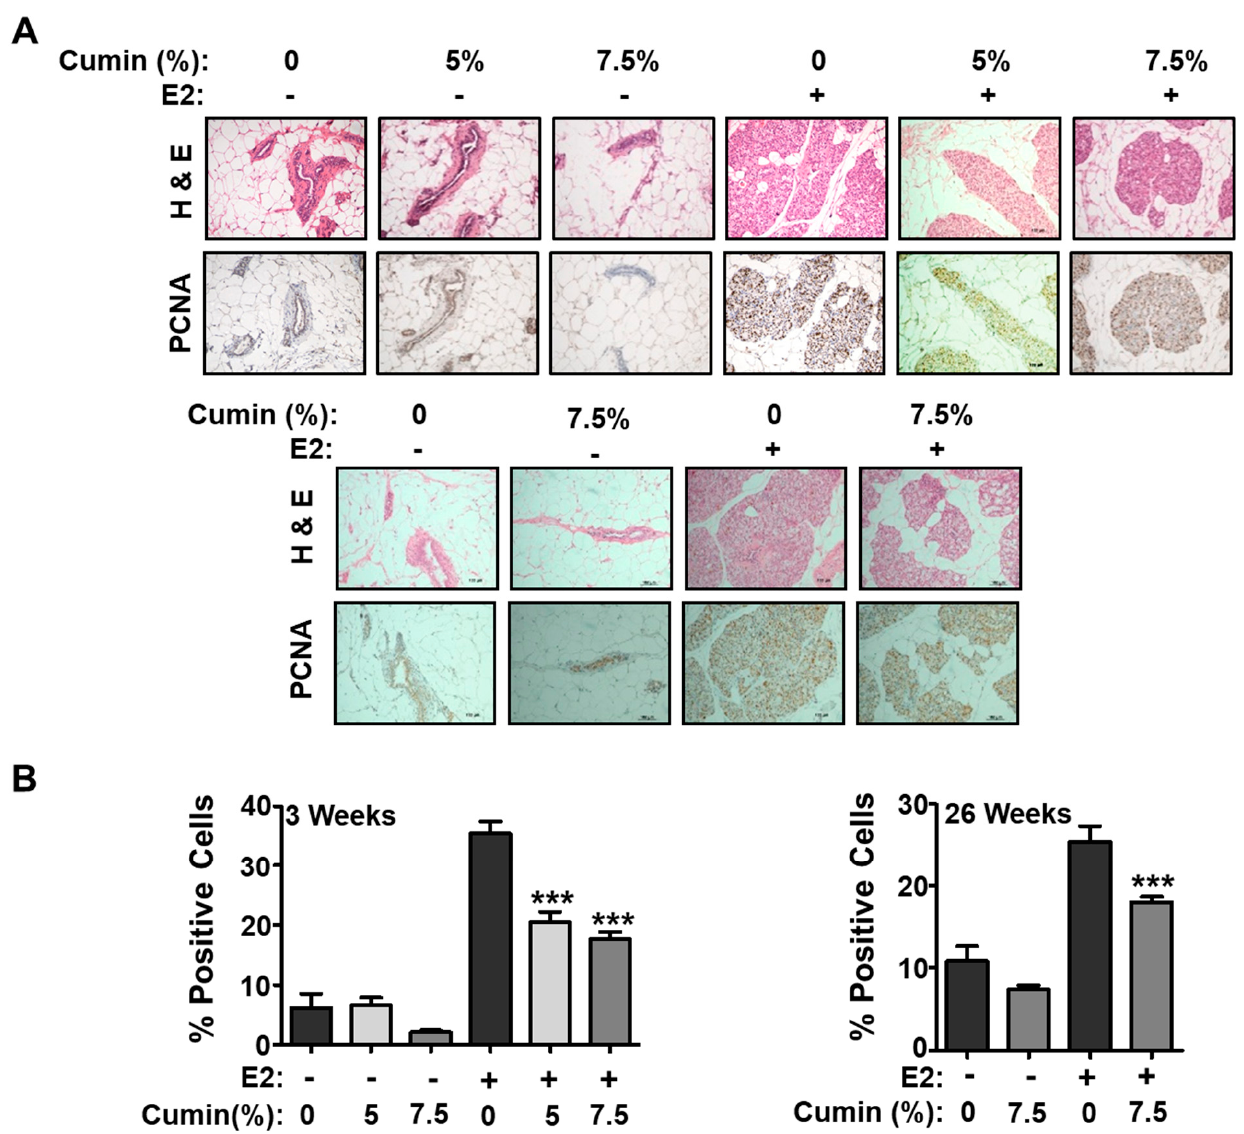
Figure 3. Effect of cumin diet on 17ß-estradiol (E2)-mediated mammary cell proliferation in the absence and presence of E2 treatment. ( A ) Representative photomicrographs (20 × magnification) of normal and hyperplastic mammary tissue following immuno-histochemical staining for proliferating cell nuclear antigen (PCNA) after 3 weeks (left panel) and after 26 weeks (right panel). ( B ) Bar diagrams show the percentage (average ± SD) of deeply stained cells for PCNA in mammary tissues (n = 5). *** p < 0.001.